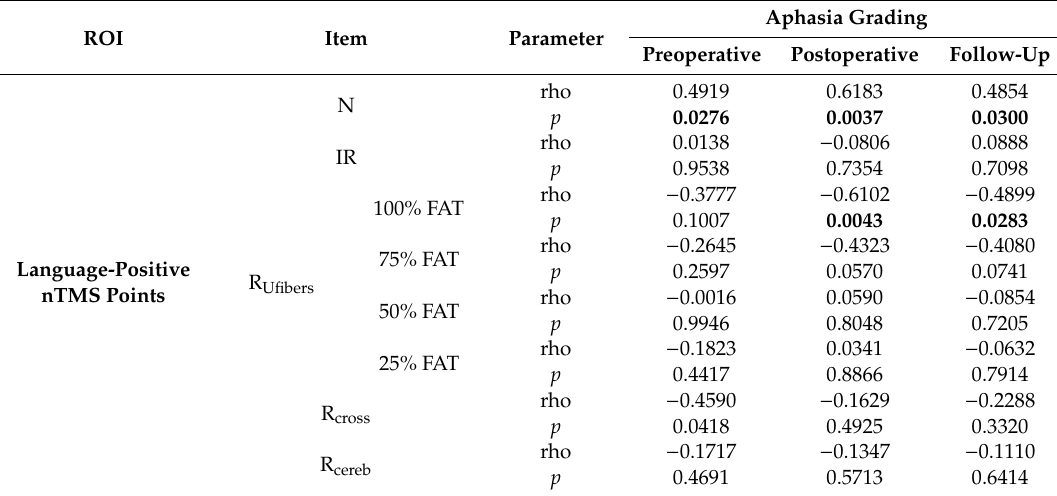
Table 3. Associations with aphasia